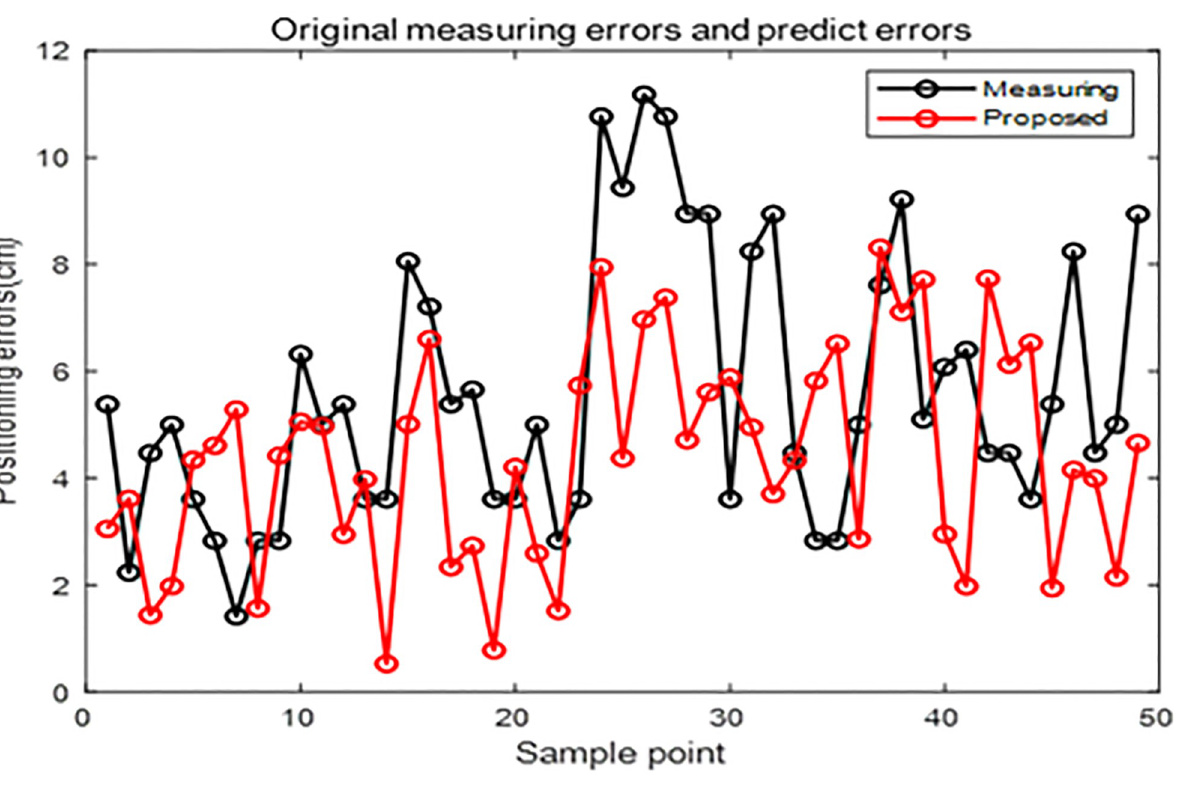
Fig 12. Measuring and predicting errors of the test dataset.